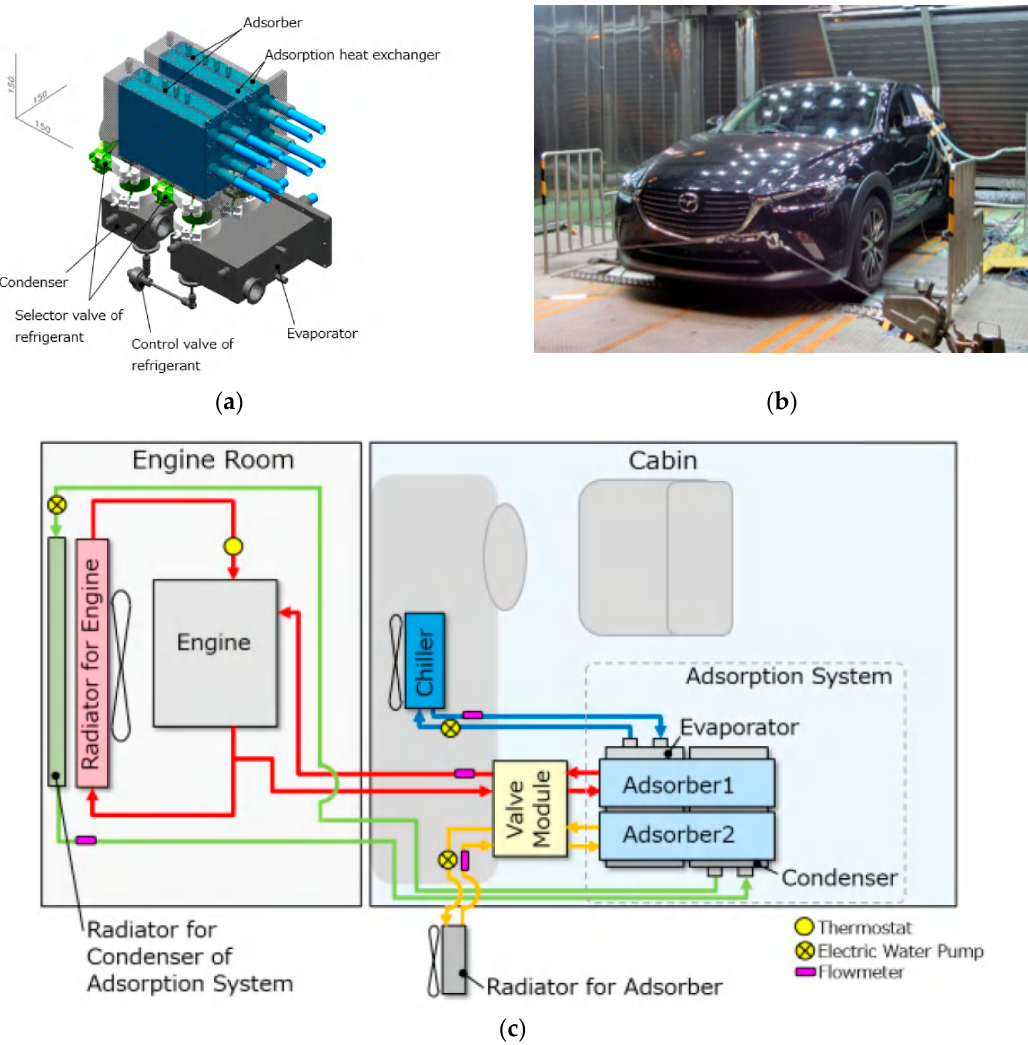
Figure 4. The 3D model and the onboard test facility of the adsorption system for automobile air conditioning. ( a ) The 3D model; ( b ) onboard test facility; and ( c ) schematics of the layout of the vehicle